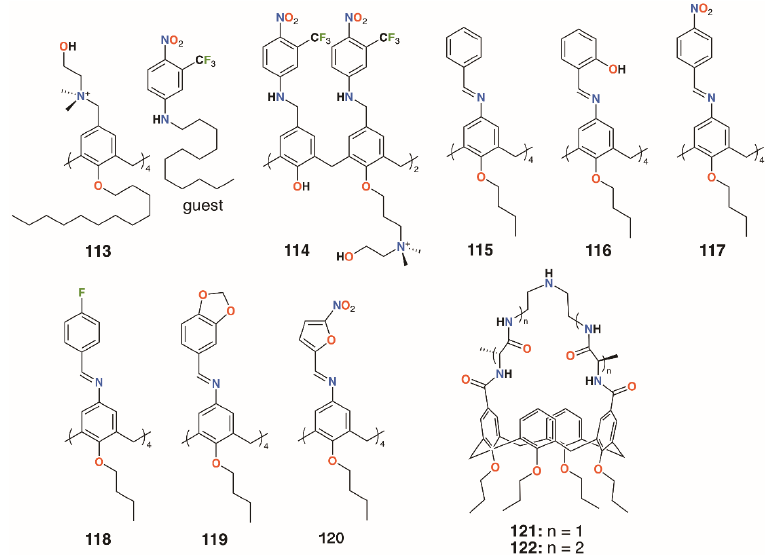
Figure 17. Antibiotic and antifungal calixarenes of Consoli and Di Fatima with Ungaro’s vancomycin Figure 17. mimics.